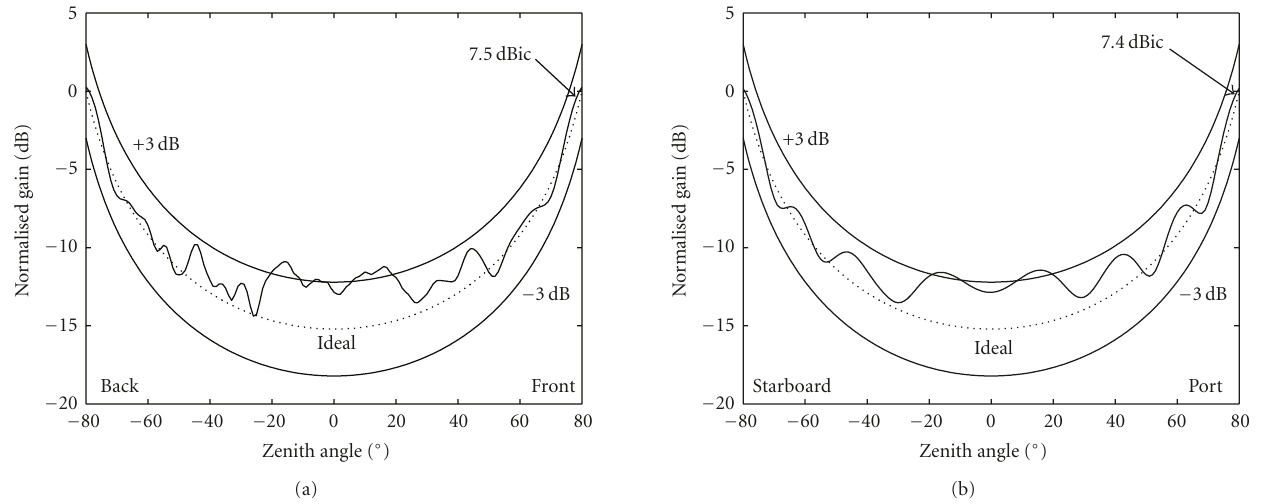
Figure 16: Principal plane radiation patterns of the 5-turn helical antenna on the gondola; (a) zenith angle 0 ◦ , (b) zenith angle 90 ◦ , normalised to minimum value of zenith 80 ◦ gain, from FEKO.